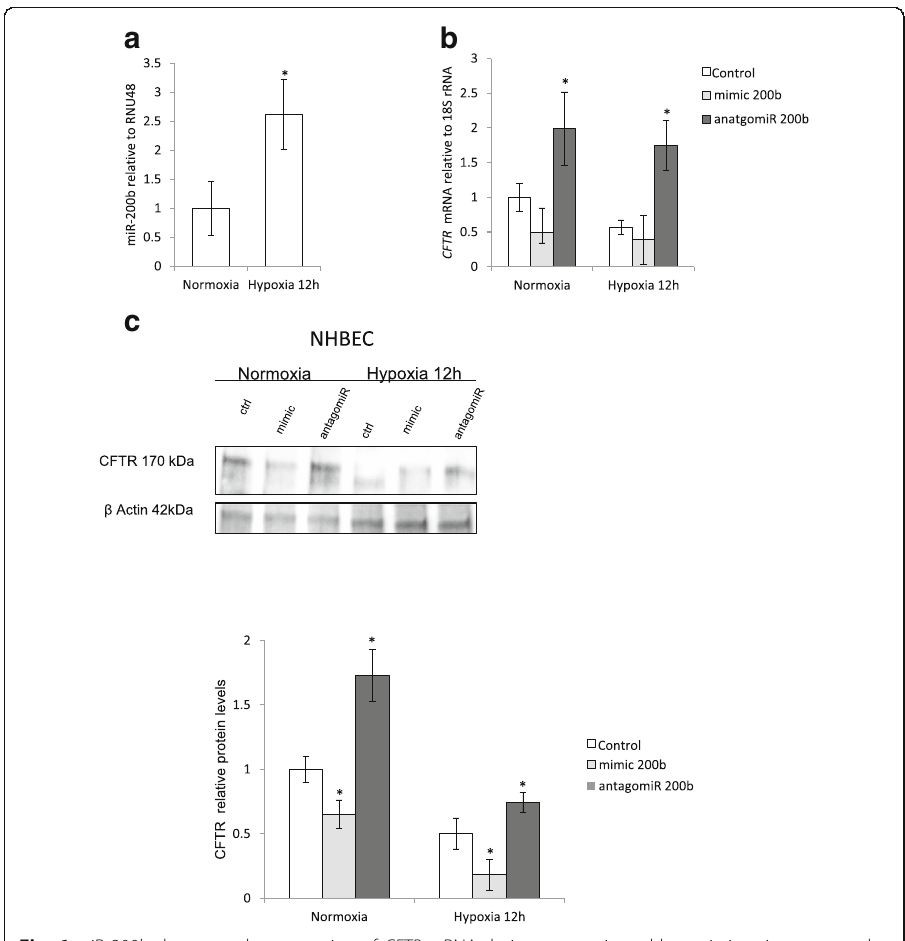
Fig. 6 miR-200b decreases the expression of CFTR mRNA during normoxia and hypoxia in primary normal human bronchial epithelial cells (NHBEC). a The levels of miR-200b after 12 h of hypoxia in NHBECs from 3 independent experiments ( n = 6) are plotted normalized to RNU44 levels and expressed as a fold change over the normoxia control. b NHBEC cells were transfected with miR-200b mimic or antagomir and the mRNA levels were monitored in qRT-PCR experiments in normoxic conditions and after 12 h of hypoxia. CFTR mRNA levels from 2 independent experiments ( n = 8) are plotted normalized to 18S rRNA levels and expressed as a fold change over the transfection control. c The corresponding changes of CFTR protein levels were monitored with SDS-PAGE and Western Blot analysis and normalized to the β -actin levels. Two individual samples (3 μ g of total protein per lane) were tested for each treatment and the experiments were repeated twice. Error bars represent standard deviations (SD). Significant changes ( P <0.05) are marked with an